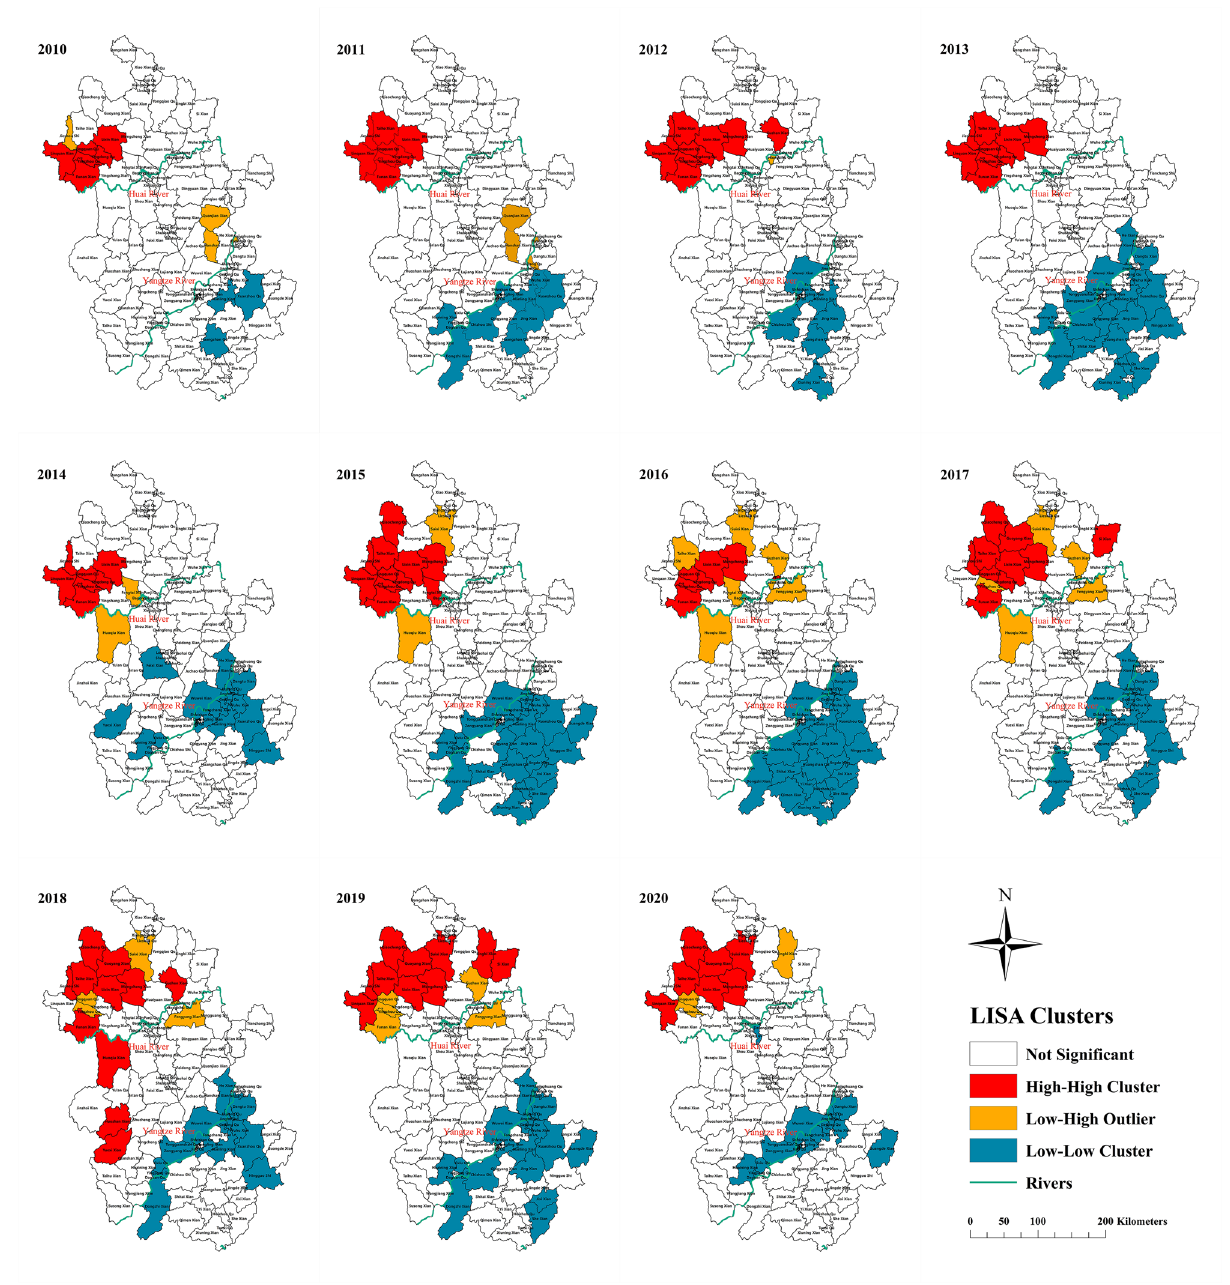
Figure 5. Yearly LISA cluster maps for scrub typhus incidence in Anhui, China, 2010–20. LISA spatial cluster map shows the center of the cluster in color. H-H indicates a statistically significant cluster of high scrub typhus incidence values; L-H represents low scrub typhus incidence values surrounded with high incidence values; L-L represents low scrub typhus incidence values surrounded with low incidence values. The base layer of the map was obtained from Resource and Environment Science and Data Center (https:// www. resdc. cn/ Datal ist1. aspx? Field TyepID=